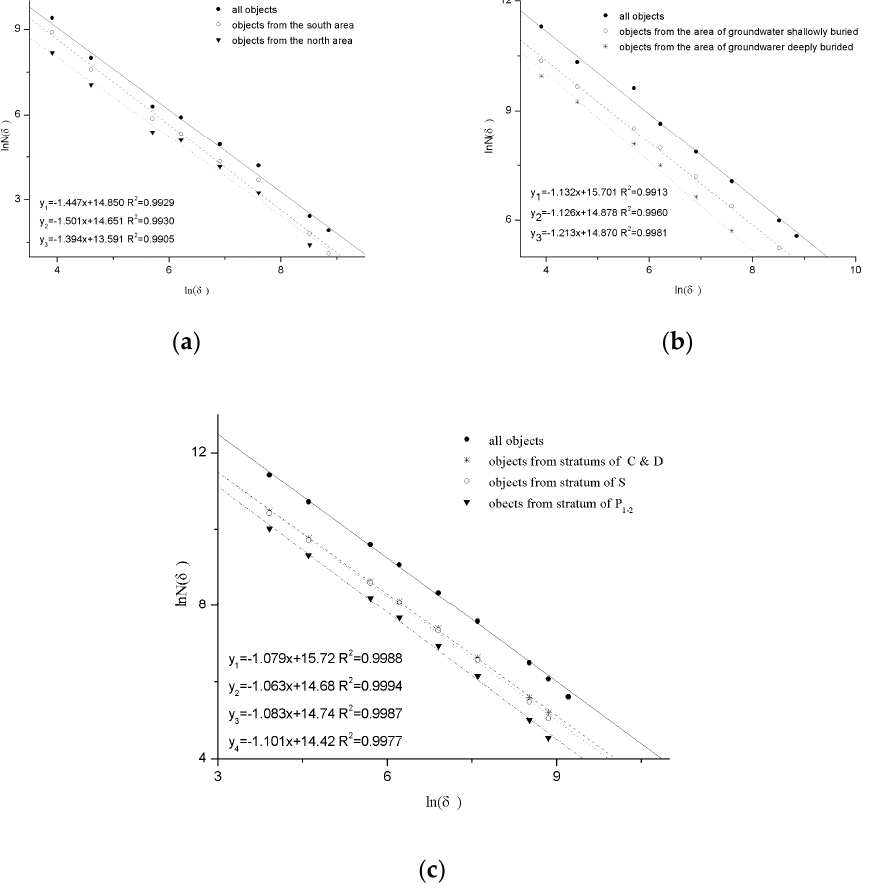
Figure 13. Relationship between ln δ and ln(N( δ )). ( a ) Dongfeng System; ( b ) Batang system; ( c ) Pingguo System.